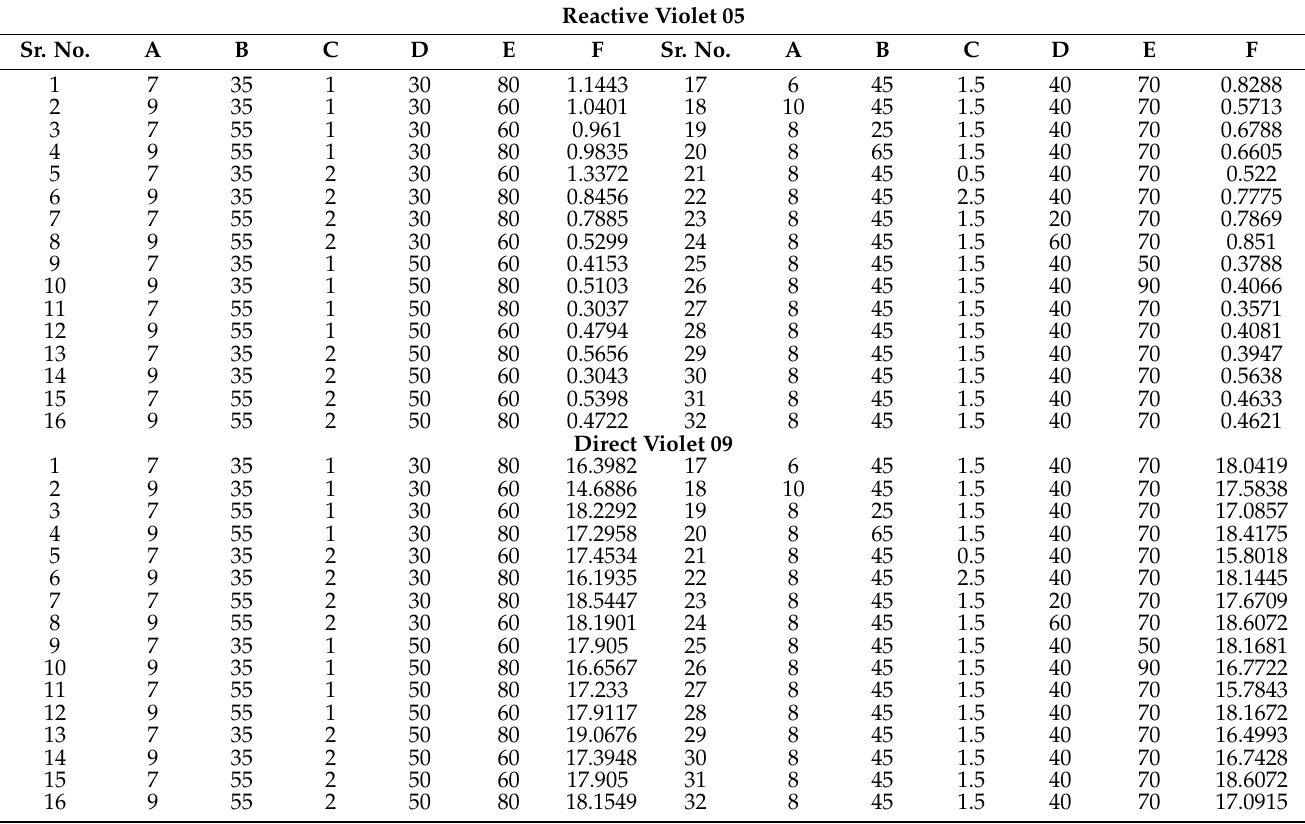
Table 3. Selection of dyeing parameters for cellulosic fabrics using Reactive Violet 05 and Direct Violet 09 dye through RSM.